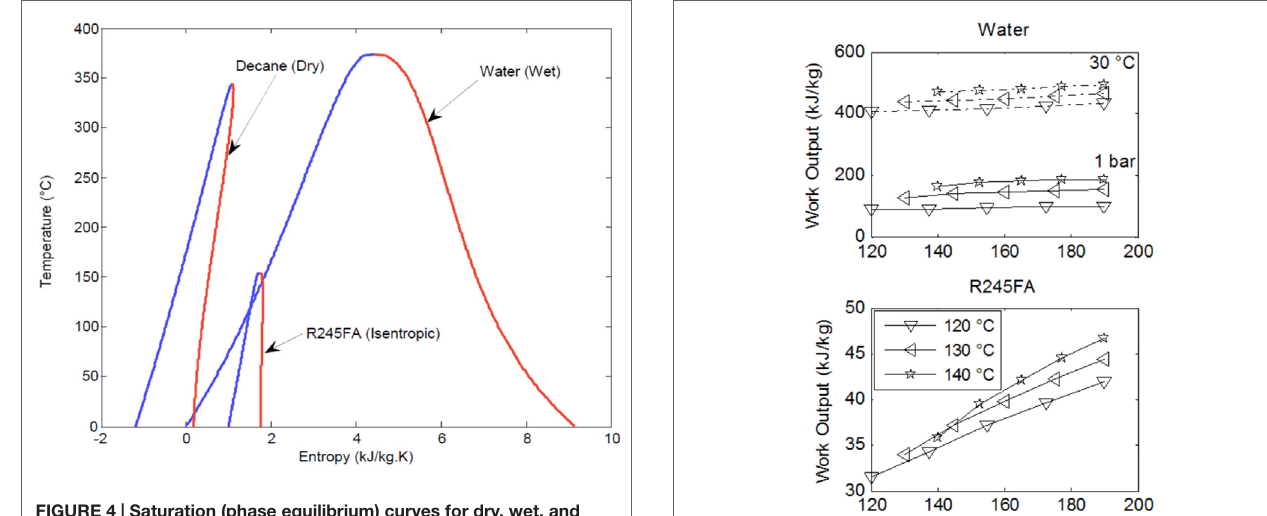
FiGURe 4 | Saturation (phase equilibrium) curves for dry, wet, and isentropic fluids on a T – S diagram .